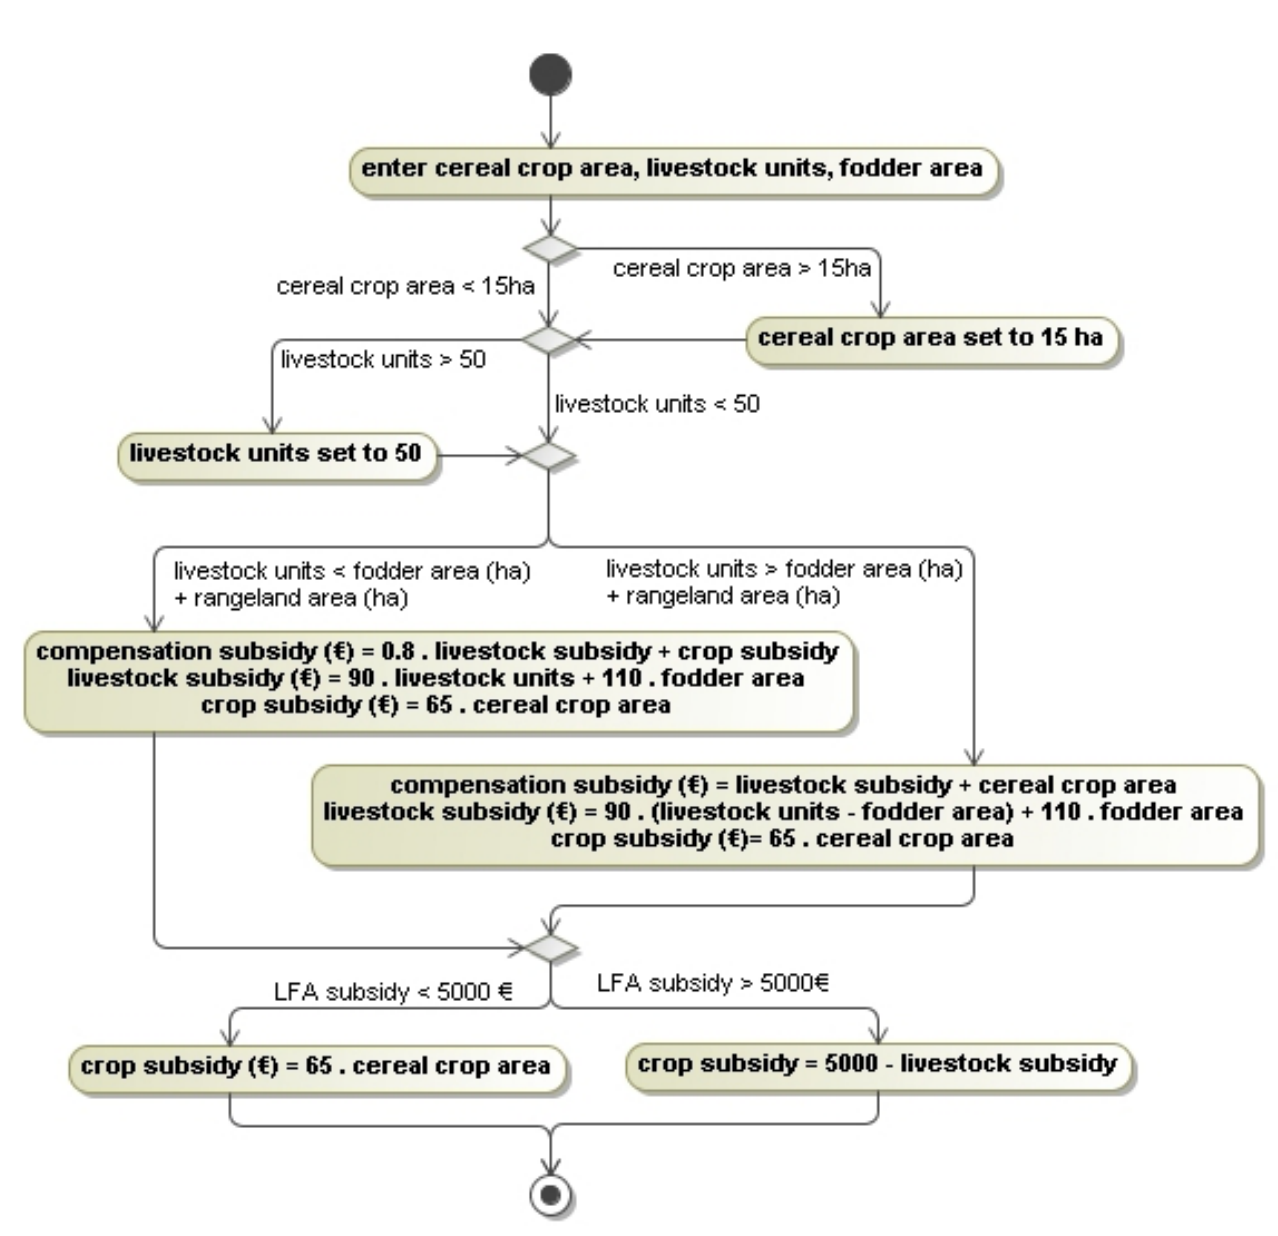
Figure 3. Less Favoured Area (LFA) subsidy model using a Unified Modeling Language (UML) Activity